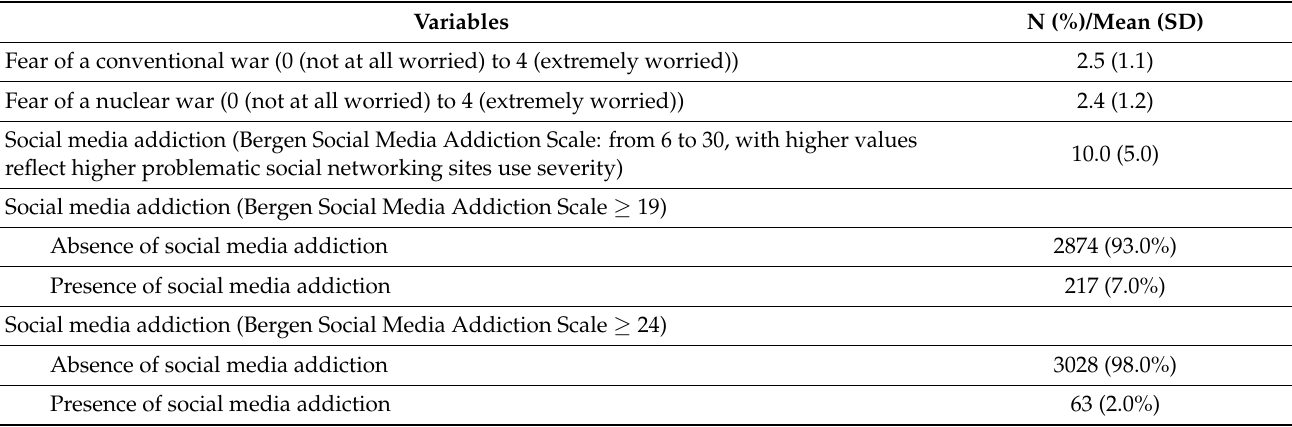
Table 1. Sample characteristics (n =